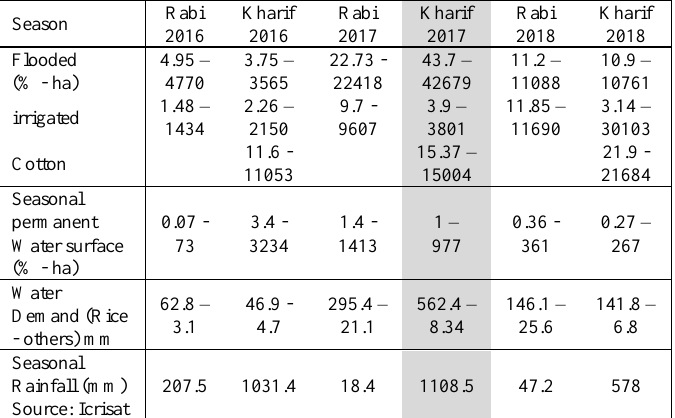
Table 1. Results of Random Forest classification using multi- temporal Sentinel-1 and 2 imagery at 10 meters, for five growing seasons: Rabi 2016 (Jan. to March 2016), Kharif 2016 (July to Nov. 2016), Rabi and Kharif 2017 and 2018. Precision and recall respectively stand for the predicted fraction of pixels classified as the appropriate class and the fraction of validation pixels that have been correctly classified. The F-score is the harmonic mean of both metrics and evaluates the relevance of the classifier. The Kappa index is an estimation of this relevance for all nine crop classes considered: rice, vegetable, maize, forest, orchard, bare ground dry areas or bush, urban area, water and cotton (if any). Technical details on the size of images stacks are detailed. Kharif 2017 column is colored in grey, to highlight the low F-scores obtained, and mark the low confidence we have on the irrigated area extents and corresponding IWD estimates.